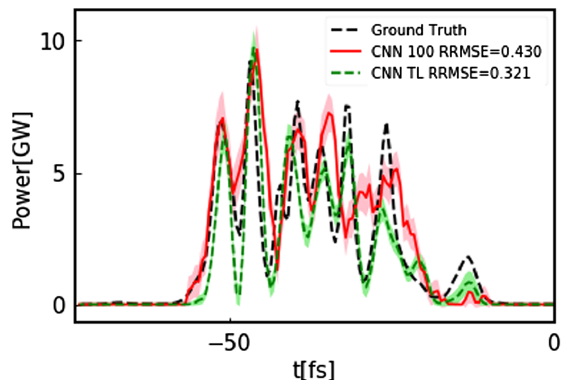
FIG. 5. Transfer learning results of the same SetMedium phase- space in Fig. 2. The red curve is the prediction of a CNN trained on only 100 samples, which shows worse performance than the TREX algorithm due to the small data set. However, using the same 100 samples and the pretrained SetLong CNN to do transfer learning, the prediction (green curve) is nearly as good as the original SetMedium CNN trained on 900 samples (Fig.